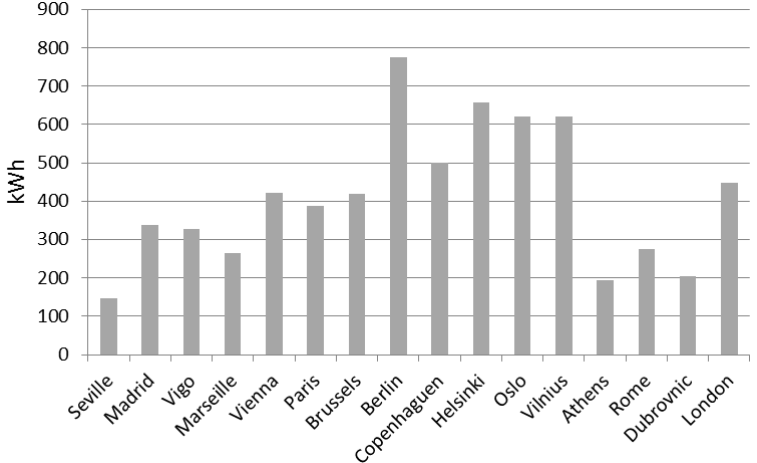
Figure 11. Comparison of annual generated power in kWh for all of the cities